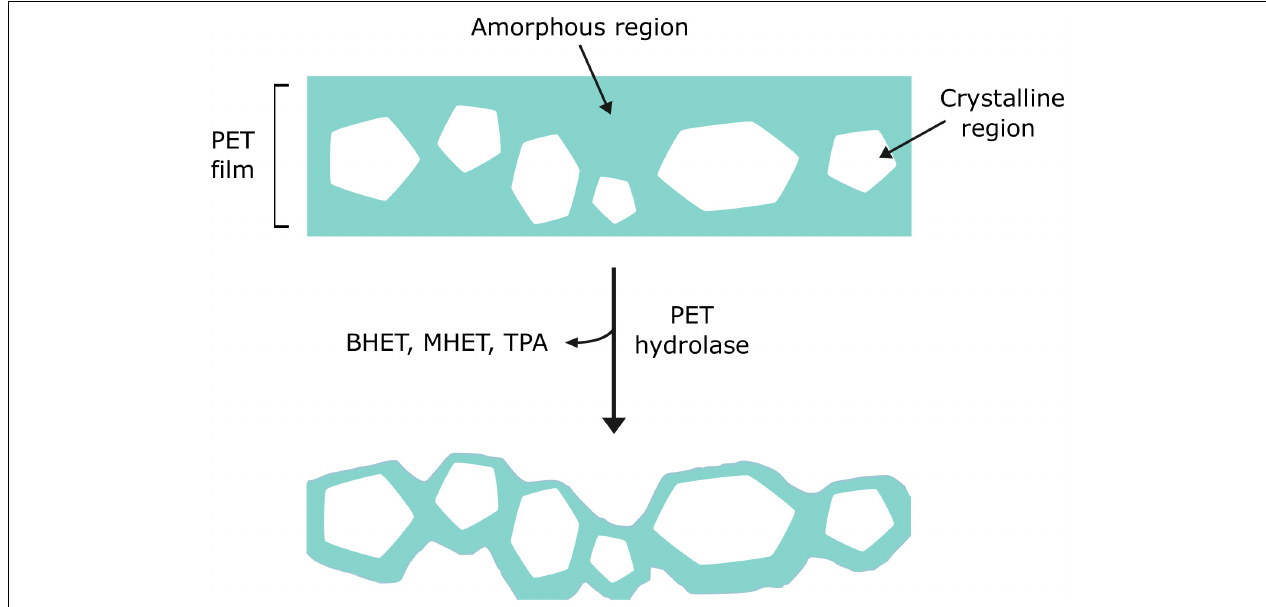
FIGURE 4 | Enzyme preference for amorphous regions of PET over crystalline regions. PET hydrolase enzymes have been shown to favor lower crystallinity, amorphous areas of PET (shown in